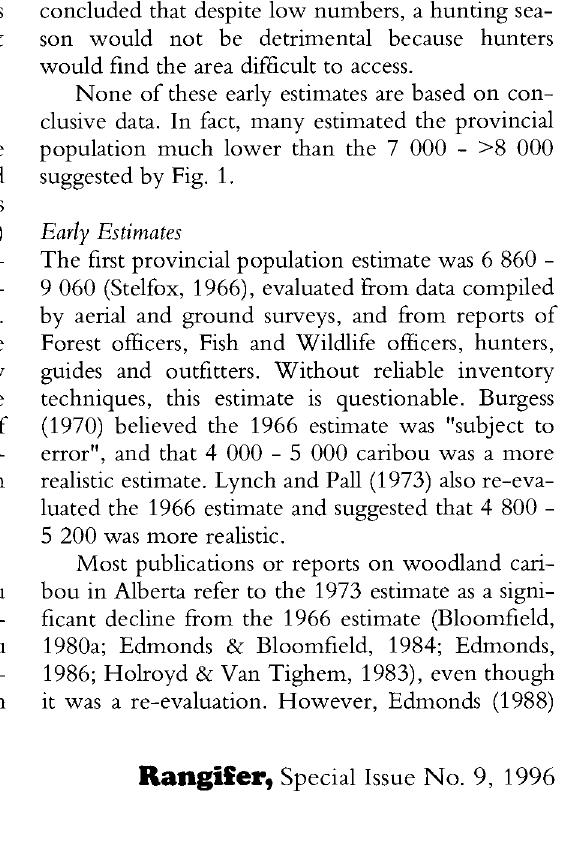
Fig. 1. Proposed woodland caribou population decline for Alberta from 1900-1986 as originally presen ted in Edmonds